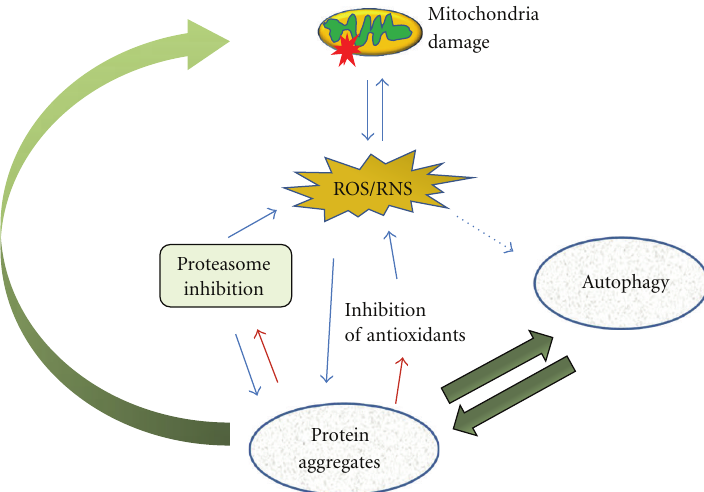
Figure 2: ROS/RNS production as a result of defective mitochondria respiratory activity can be induced by a number of factors like protein aggregates. Reactive species can also be generated by other cellular oxidases. These ROS/RNS species can modify several proteins which can stimulate and/or inhibit autophagy. In addition, reactive species produced or not in the mitochondria can target this organelle and induce further damage to